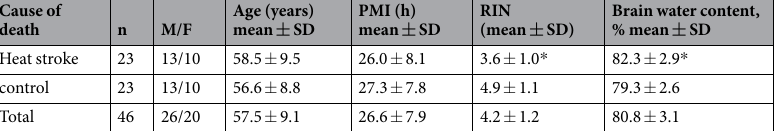
Table 1. Case profiles n = 46. Significantly lower RIN values were detected in heat stroke group as compared to the control group ( * p < 0.05). There was a significant increase in brain water content in the heat stroke group as compared to the control group ( * p <